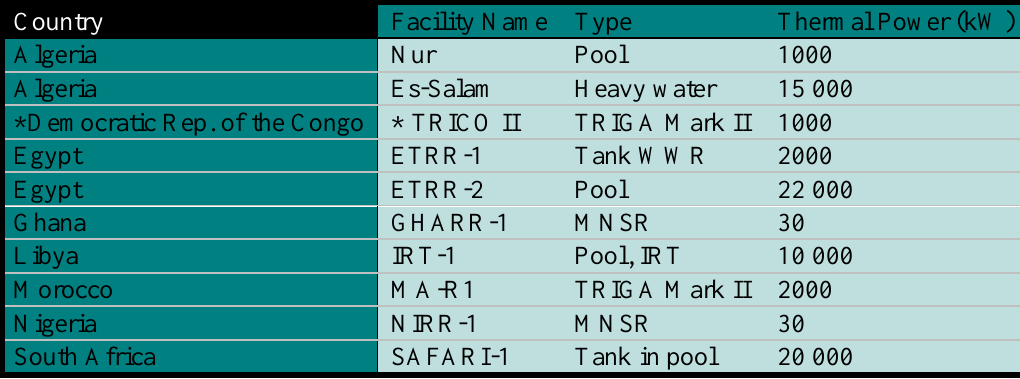
Figure 1. Research reactor in Africa (International Atomic Energy Agency, 2011) * Currently on extended shutdown